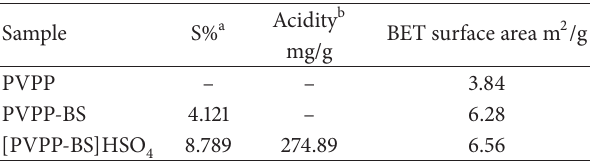
a Weight percentage of S element determined by an elemental analyzer b Determined as KOH mass consumed for neutralization. Table 2: Esterification of n-butanol and acetic acid under